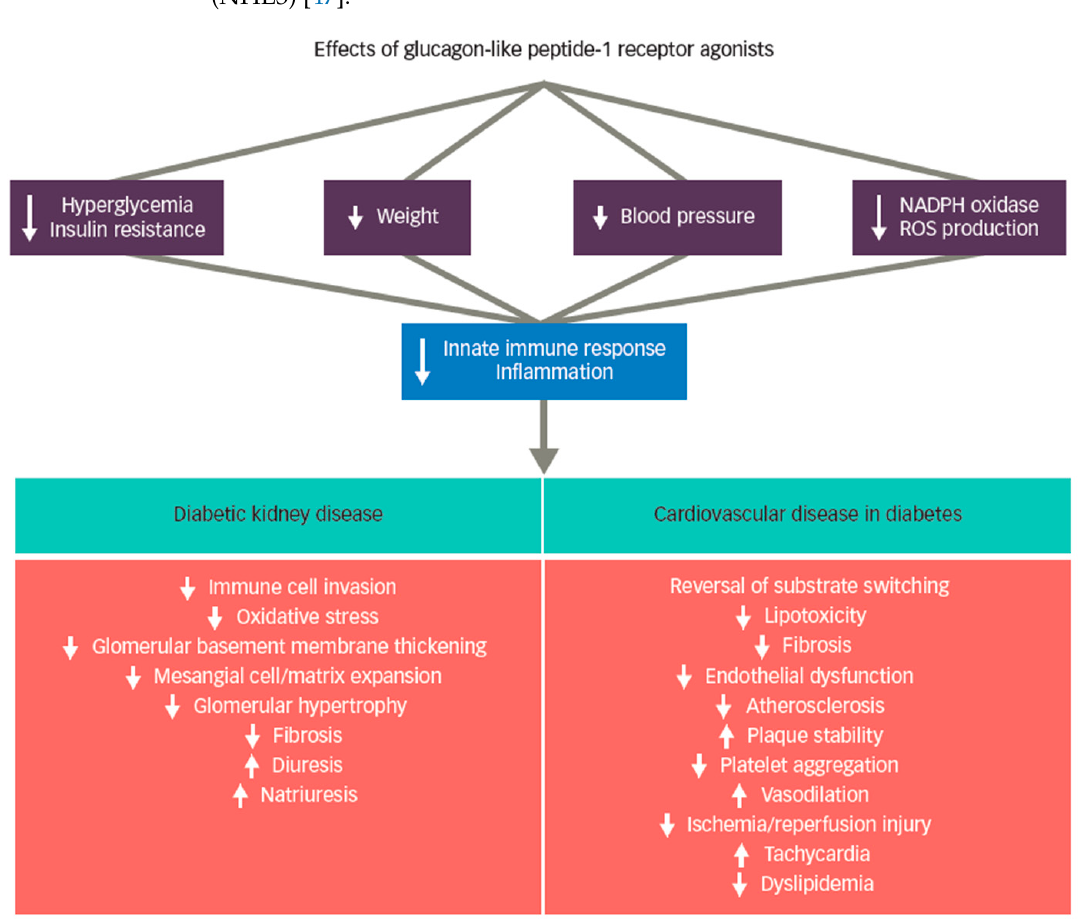
Figure 1. Putative mechanisms of GLP-1 receptor agonist therapies on DKD and ACVD.